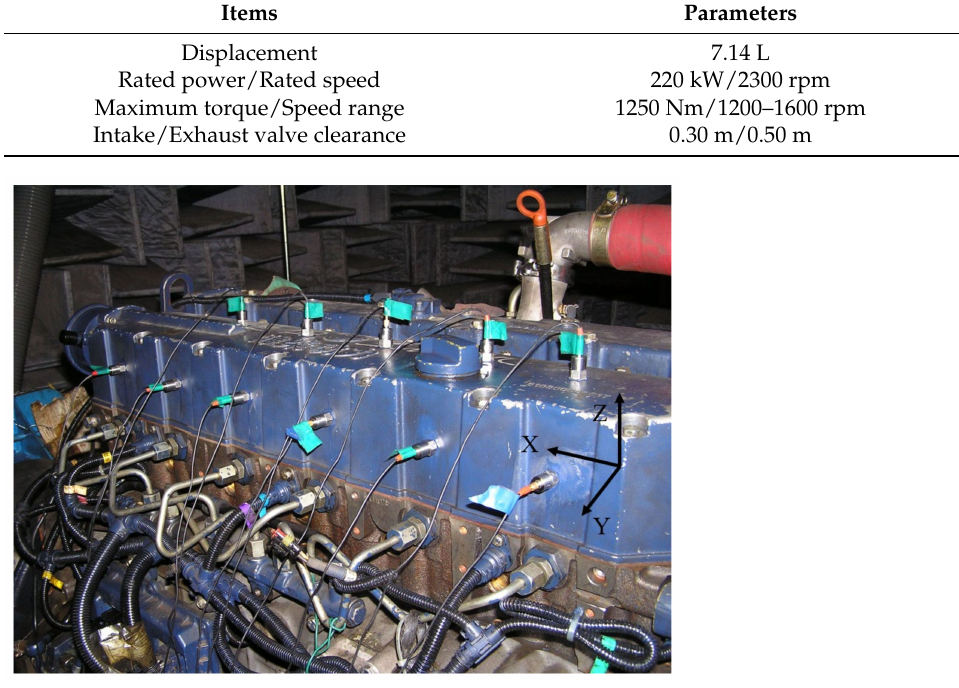
Figure 1. Sensor positions and coordinate direction. Table 2. Experimental instrument